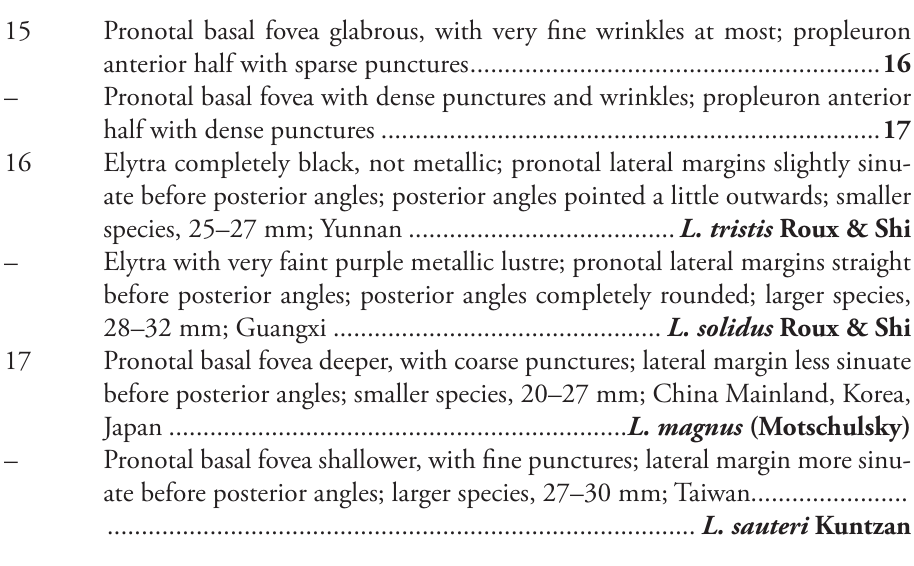
Type locality. China, Guangdong: Nanling (24.93°N, 112.99°E), altitude 1587 m. Type material. Holotype: male (IZAS), body length = 20.4 mm, board mounted, genitalia preserved in 100% ethanol in microvial pinned under specimen, “China, Guangdong / Ruyuan, Nanling / pitfall trap / 24.932039N, 112.996099E”; “1587m, 2017.VI.4-7 / Liu Y. Z. & Yu S. P. lgt., / Insititude of Zoology., CAS.”; “HOLO- TYPE ♂ / Lesticus auripennis sp. n. / des. ZHU & SHI, 2018” [red label]. Paratypes (two males and six females): one male and one female (IZAS), the same data as holo- type but labeled as paratype. One female (IZAS), “China, Guangdong / Ruyuan, Nan- ling / pitfall trap / 24.93077N, 112.994692E”; “1708m, 2017.VI.4-7 / Liu Y. Z.